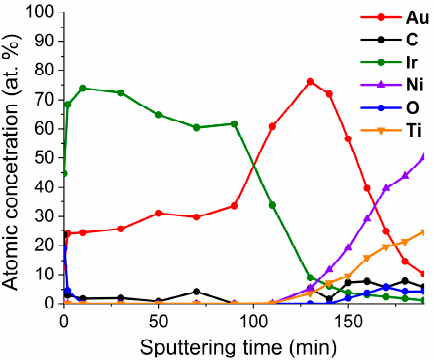
Figure 10. The XRS depth profiles of the element concentrations for the Ir/Au/TiNi sample.